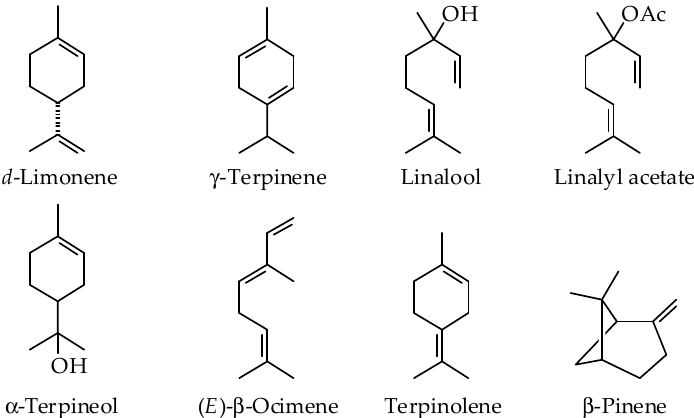
Figure 1. Chemical structures of key volatile components in Citrus essential oils.